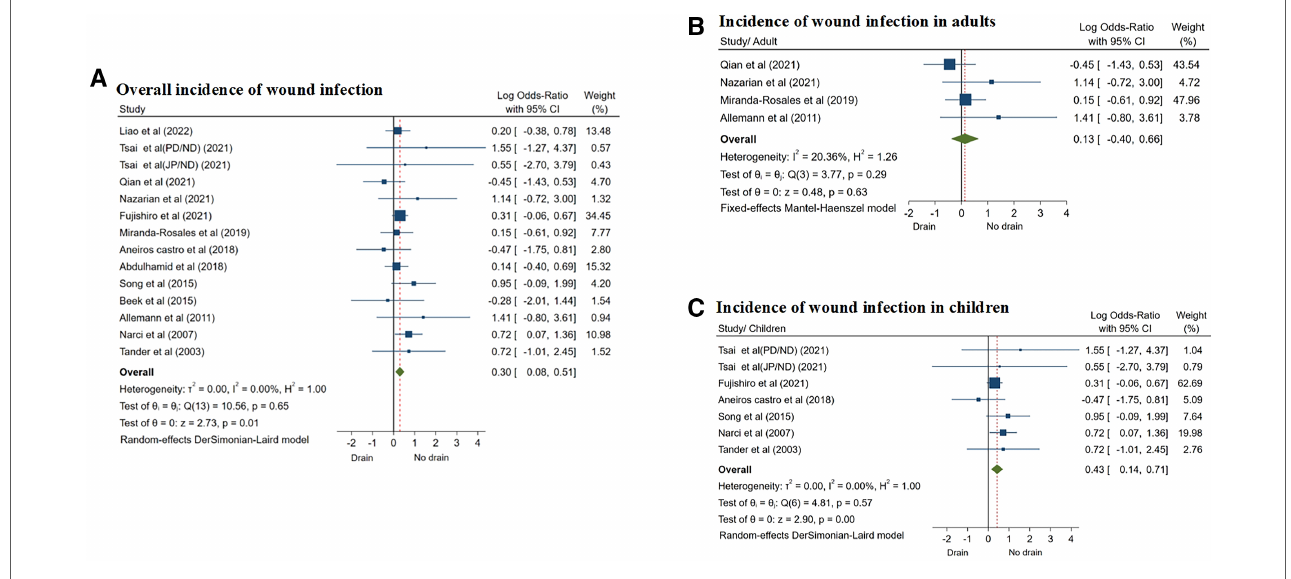
FIGURE 6 Forest plots of meta-analysis and subgroup meta-analysis comparing wound infection, ( A ) overall incidence of wound infection; ( B ) incidence of wound infection in adults; ( C ) incidence of wound infection in children.